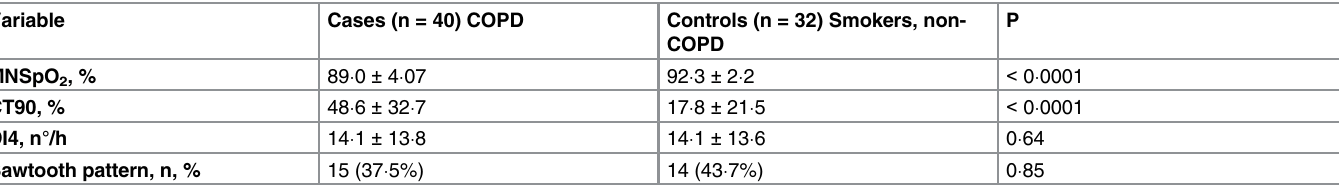
Table 7. Results of the nocturnal